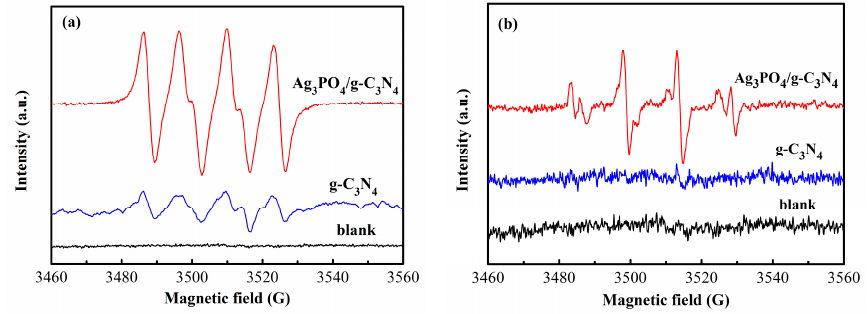
Figure 12. ESR signals of ( a ) DMPO ‐ ∙ O 2 − in methanol dispersion; and ( b ) DMPO ‐ ∙ OH in aqueous dispersion with visible ‐ light irradiation.